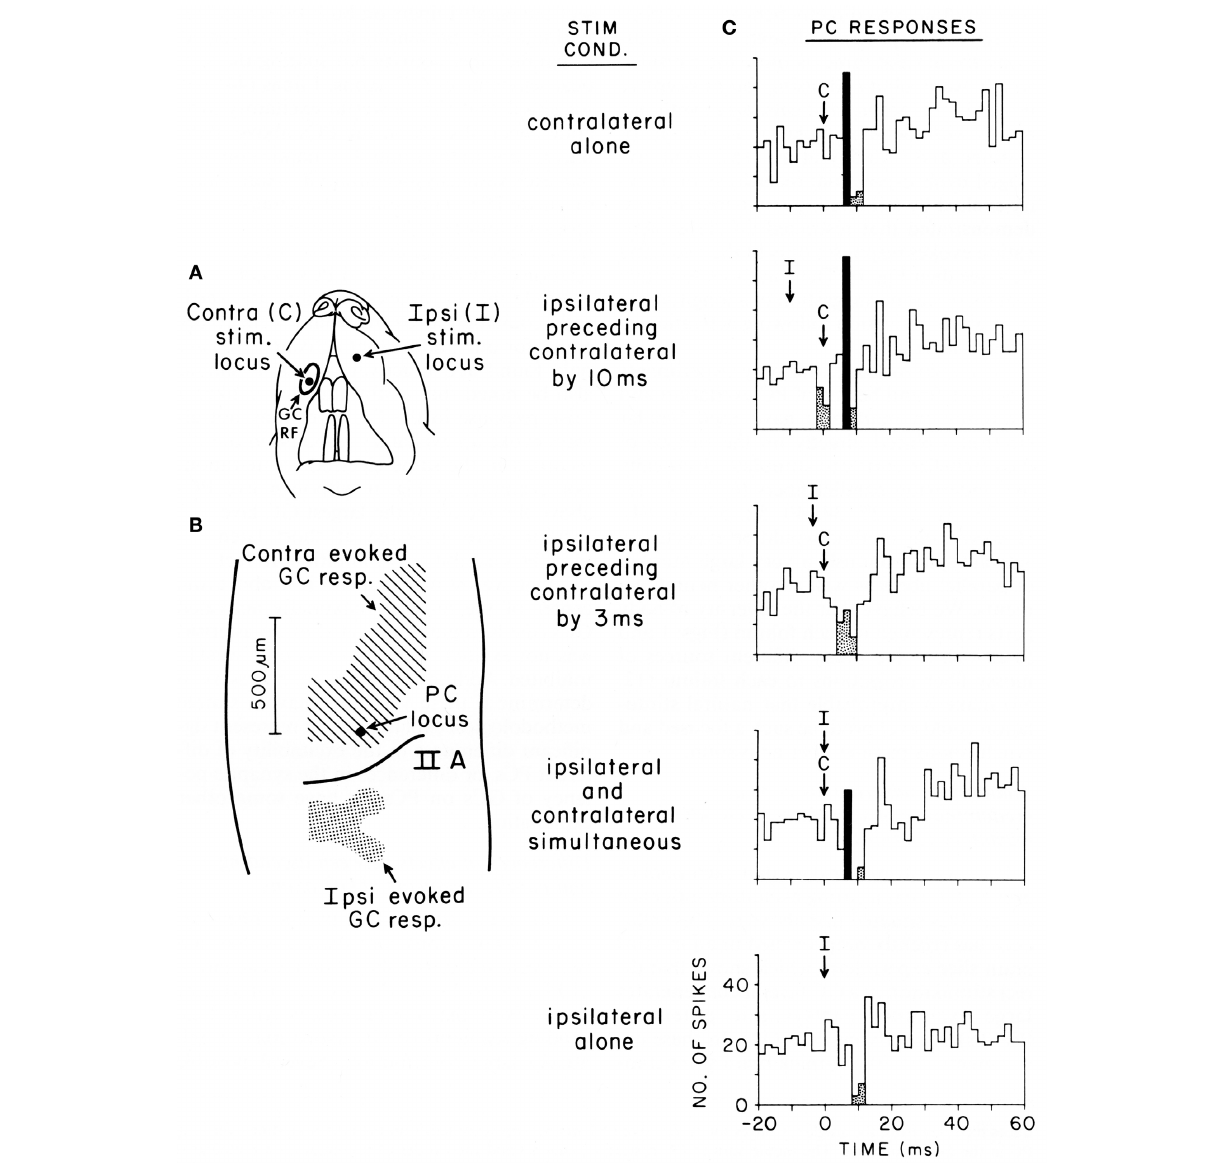
temporal sequences of the two peripheral stimuli are shown in (C) . (C) Five peri-stimulus time histograms representing the responses of the same Purkinje cell to stimulation of the two peripheral stimuli in different temporal sequences. Statistically significant increases in spiking activity are shown in black, while statistically significant decreased spiking is shown stippled. For analysis of results see text. Reproduced with permission from Bower and Woolston,